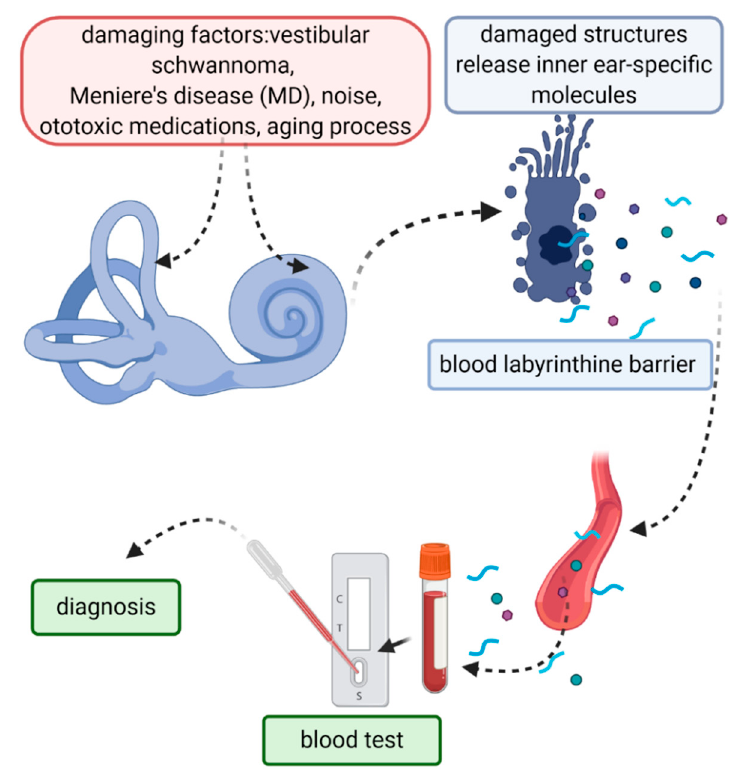
Figure 2. The identification of inner-ear-specific and disease-specific molecular biomarkers should in the future improve the otologic diagnosis and prognosis. Created with BioRender.com. Supplementary Materials: The following are available online at www.mdpi.com/xxx/s1, Detailed search strategies.